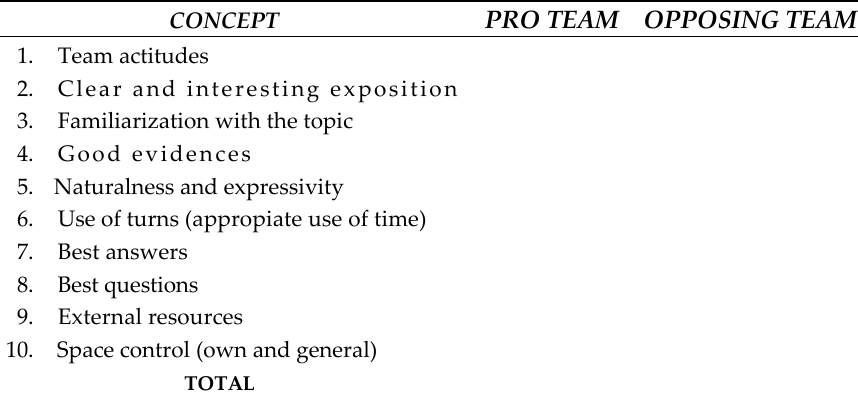
Table 1. Scoring checklist for evaluating the debate by the students.